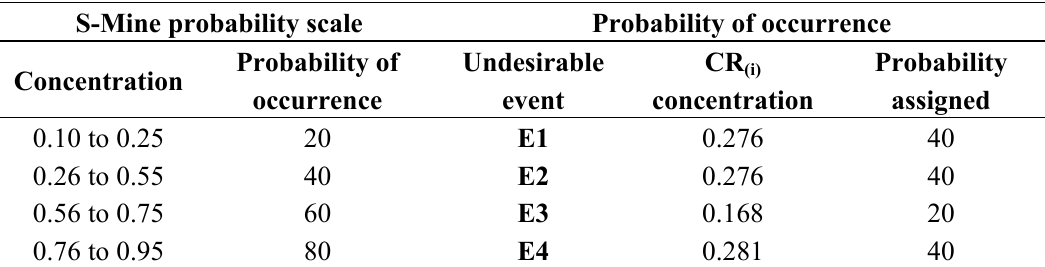
Table 6. Calculation of the probabilities of occurrence of